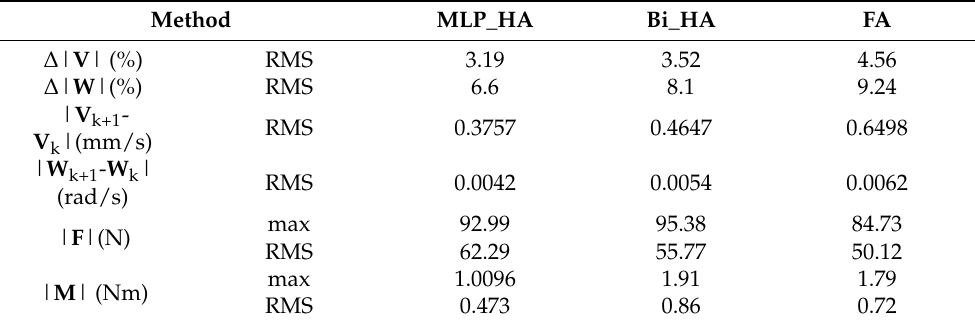
Table 8. Estimated errors.